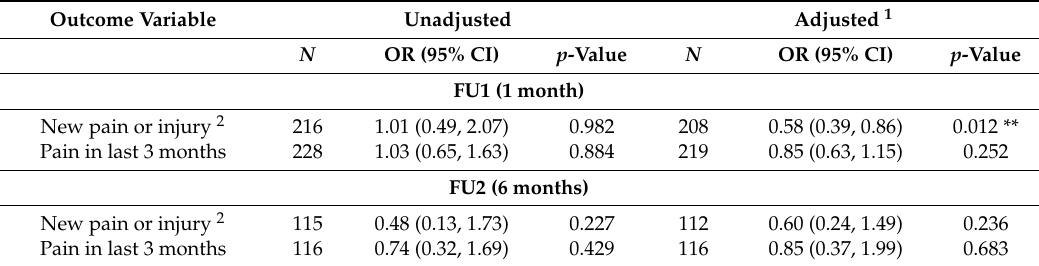
Table 3. Effects of ARM intervention on Pain and Injury at 1-month and 6-months post-intervention while adjusting for baseline level of outcome variable.